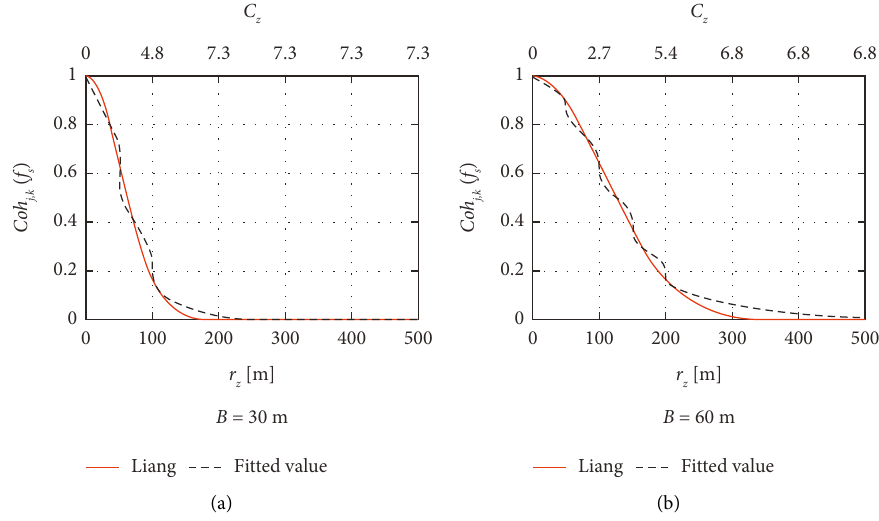
Figure 9: Vertical correlation at vortex shedding frequency for wind-induced torque: D/B �